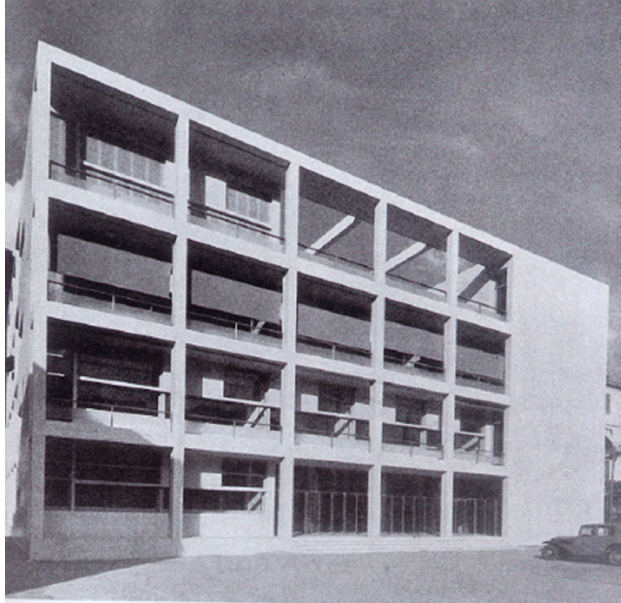
Figure 14. Casa del fascio by Giuseppe Terragni. Como (1932–1936). Photo from (Sartoris 1941, p. 387).